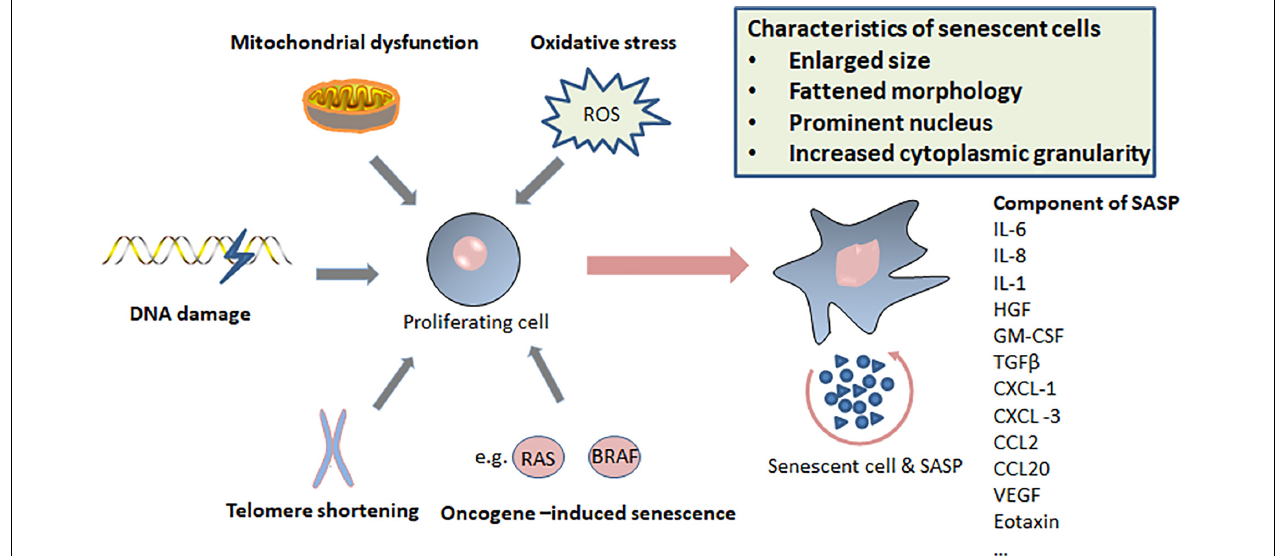
FIGURE 2 | Triggers of senescence, characteristics of senescent cells, and components of senescence-induced secretory phenotype (SASP).